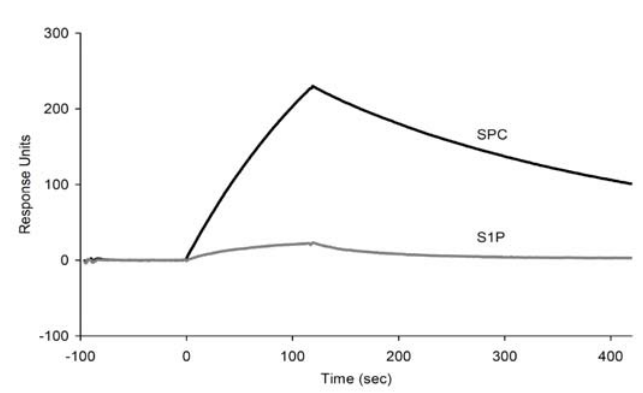
Figure 7. Binding analysis of the m012 aptamer to SPC and S1P using SPR. The biotinylated SPC and S1P were immobilized on each flow cell at similar amounts (~250 RU). 400 nM aptamer was injected over the ligands for 2